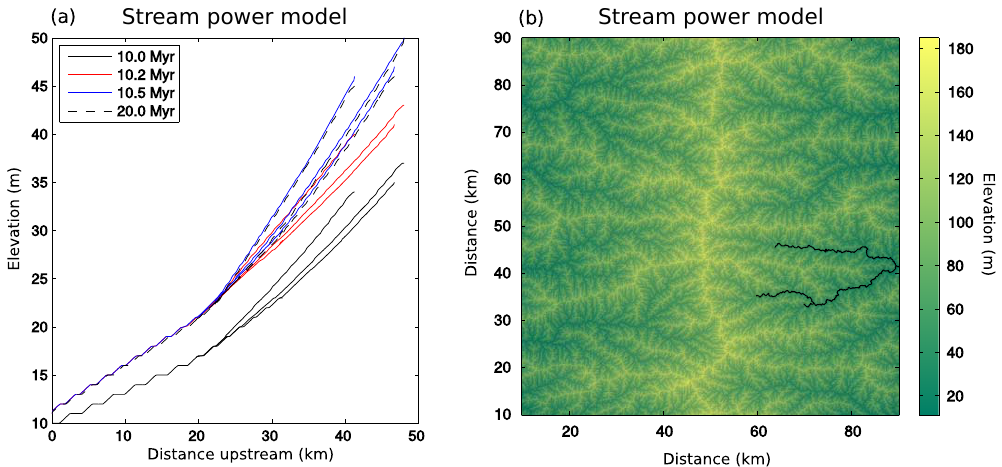
Figure 8. Stream power model evolution due to a reduction in precipitation. (a) Selected river-long profile response to a change in pre- cipitation. The black line is the profile just before a factor of 2 reduction in precipitation. The red and blue lines are 200 and 500kyr after the reduction in precipitation. The dashed black line is the steady-state profile. (b) Trunk stream used for the analysis with the steady-state